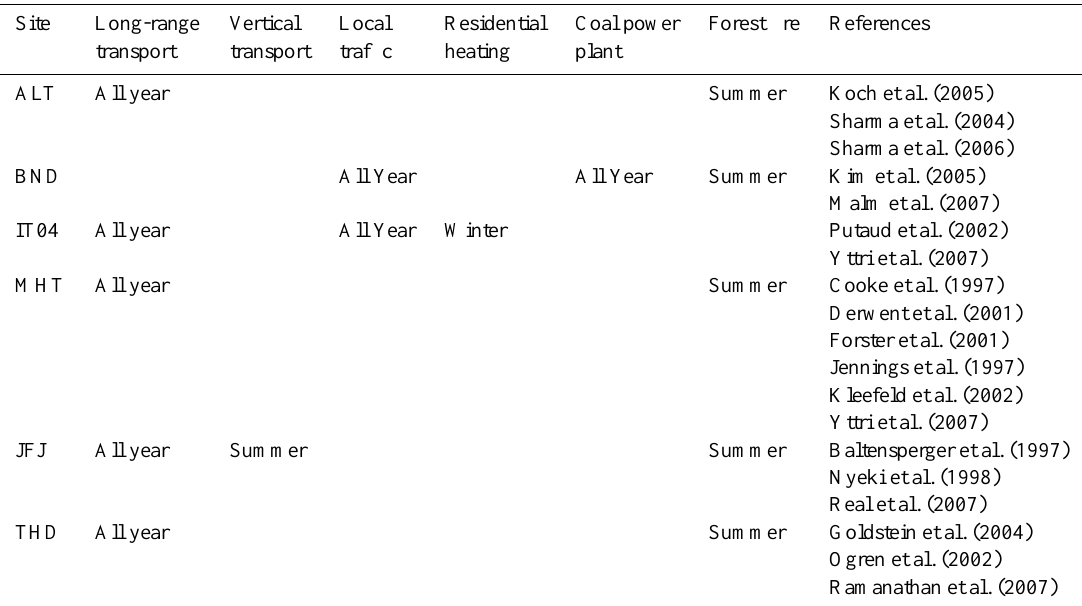
Table 2. Sources and seasonality of light absorbing aerosol at the monitoring